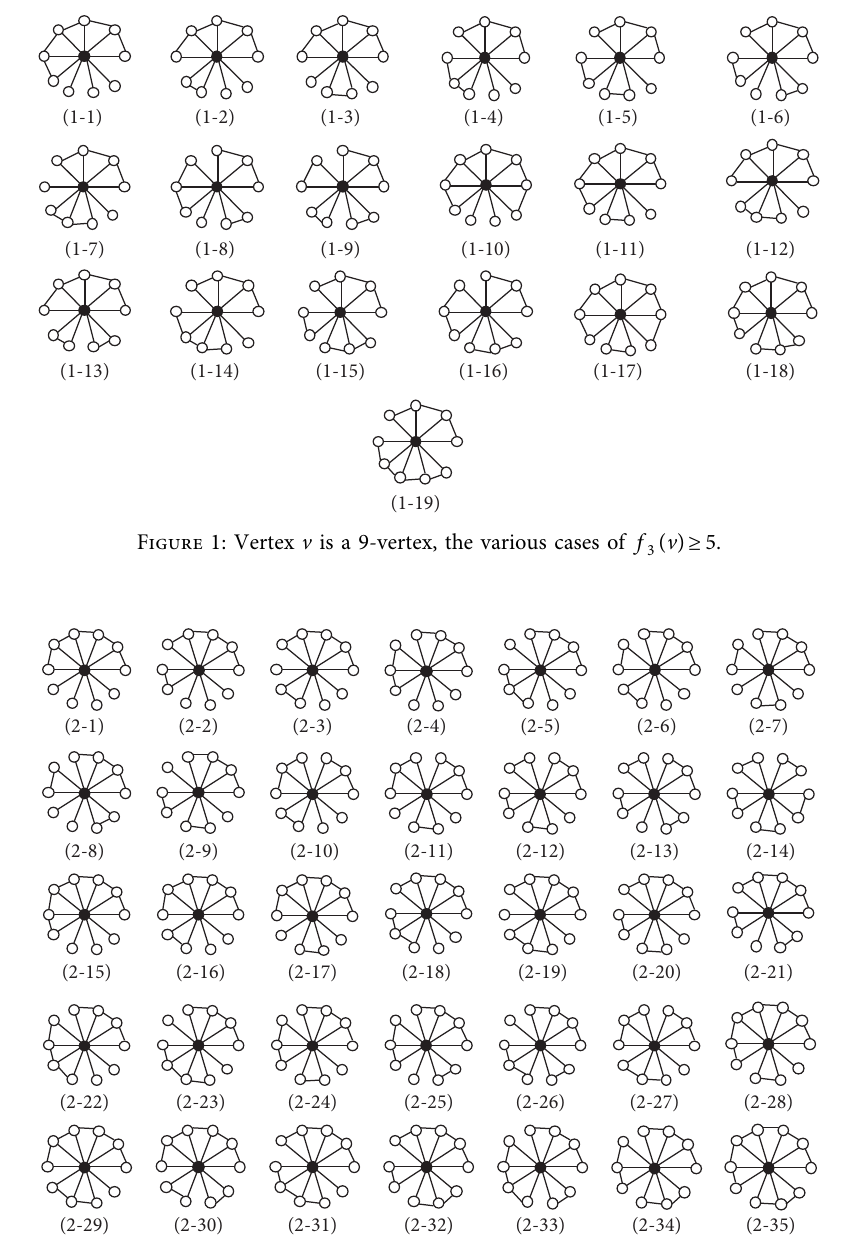
Figure 2: Vertex v is a 10-vertex, the various cases of f